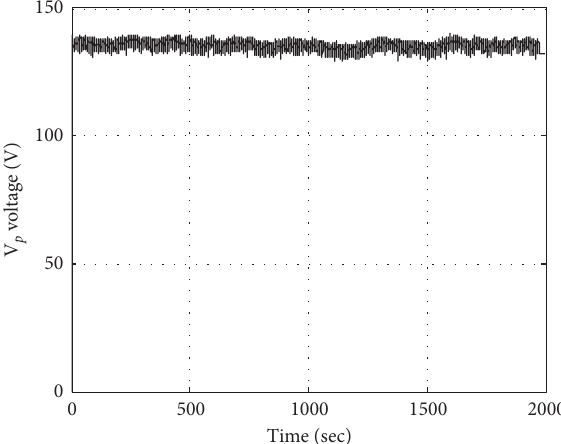
Figure 15: Evolution of real voltage of